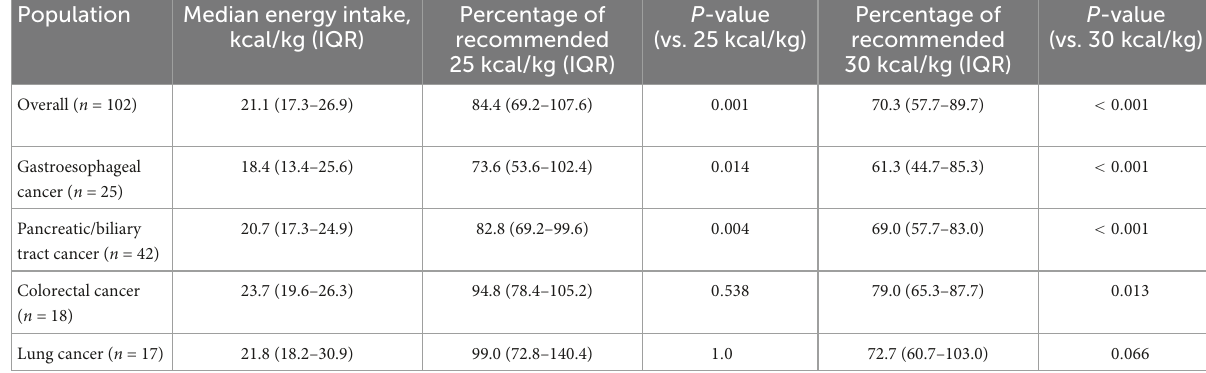
TABLE 2 Actual daily energy intake and European Society for Clinical Nutrition and Metabolism (ESPEN)/European Society for Medical Oncology (ESMO)-recommended energy intake.